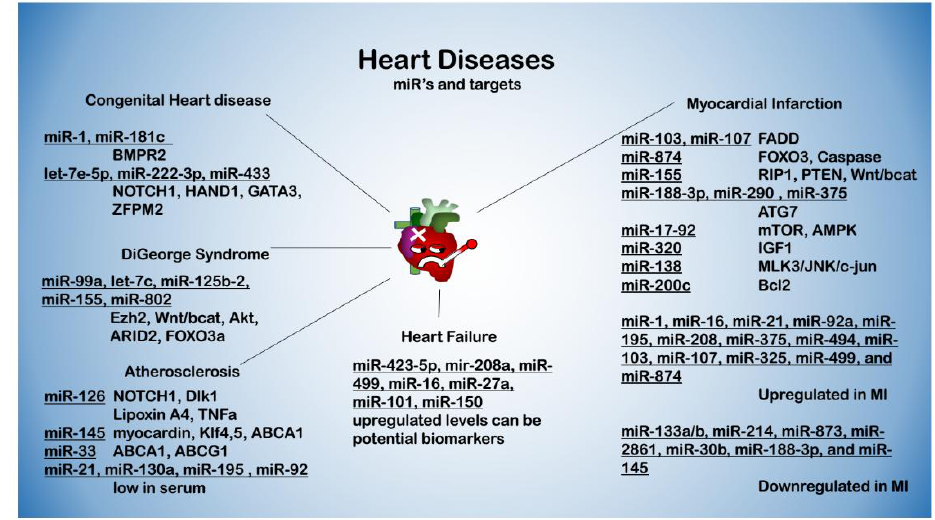
Figure 3. Major miRNAs (underlined) and targets in heart diseases (congenital heart diseases, DiGeorge syndrome, atherosclerosis, heart failure, myocardial infarction, and biomarkers). DiGeorge syndrome is a direct result of deletion in region 8 of chromosome 22, leading to a loss-of-function mutation on TBX1 and